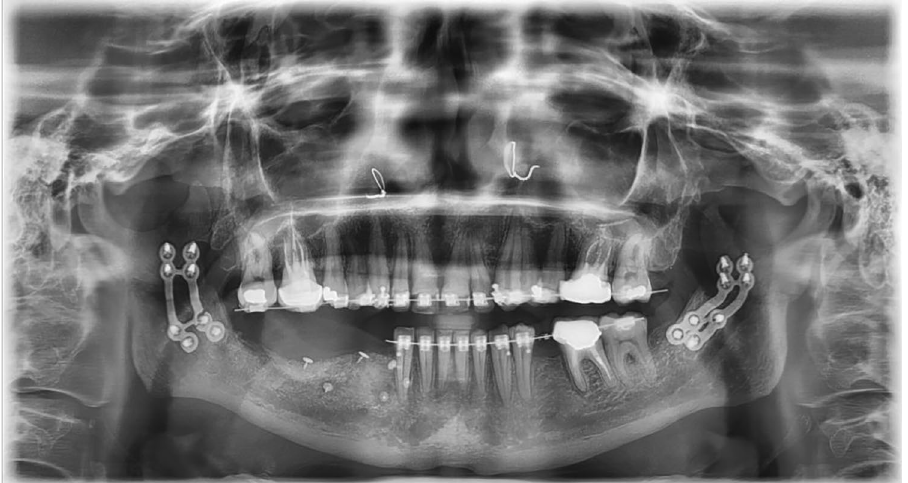
Figure 10. A fixation fracture that occurred in our clinical experience with a double-plate in the anterior